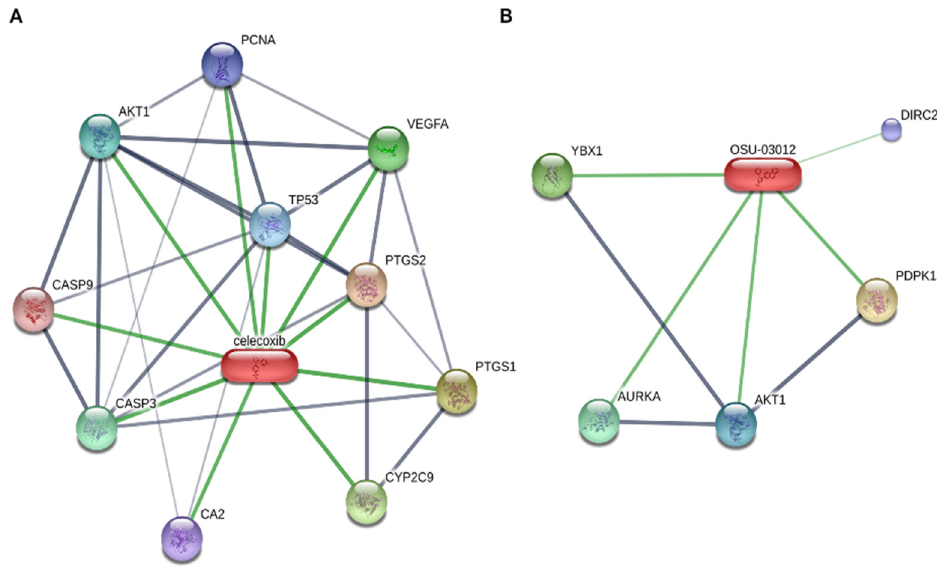
Figure 3. Proteins bound by celecoxib ( A ) or OSU-03012 ( B ). Data were retrieved from STITCH database (www.stitch.embl.de accessed on 29 April 2021).